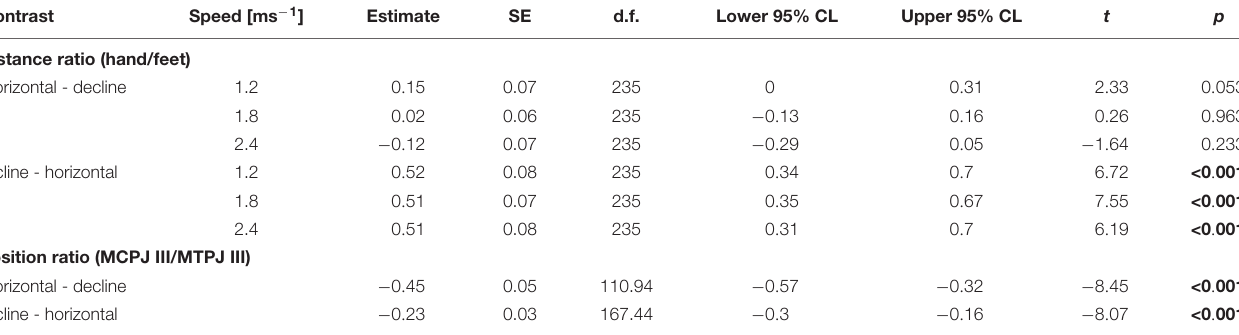
Incline - horizontal − 0 .